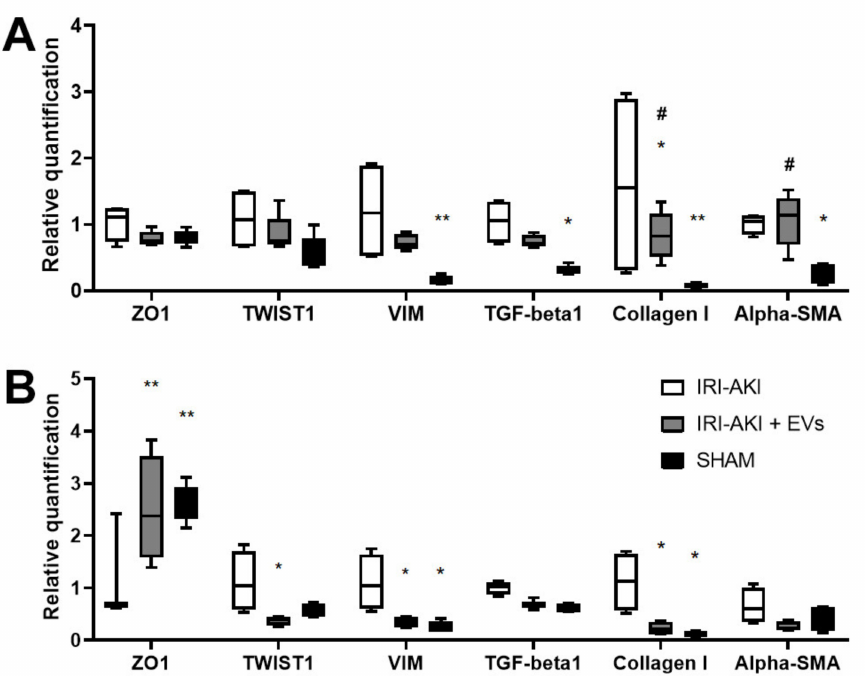
Figure 8. The effect of HLSC-EVs on renal fibrosis and EMT in IRI-AKI mice that were sacrificed two and three days after the surgery. ( A , B ) Real-Time PCR analysis of the expression of genes that are related to of EMT ( TWIST1, VIM , and ZO1 ) and to fibrosis ( TGF-beta, collagen I , and alpha-SMA ) in kidney of SHAM ( n = 5), of IRI-AKI ( n = 4), and of IRI-AKI + EVs ( n = 6) mice that were sacrificed two days after the surgery ( A ), and of SHAM ( n = 5), of IRI-AKI ( n = 4), and of IRI-AKI + EVs ( n = 4) mice that were sacrificed three days after the surgery ( B ). The mean ± SD was calculated using ∆∆ Ct method, by comparing the gene expression levels of each group with the ones of the IRI-AKI group. Normalization was performed using GAPDH as the housekeeping gene. Statistical analysis